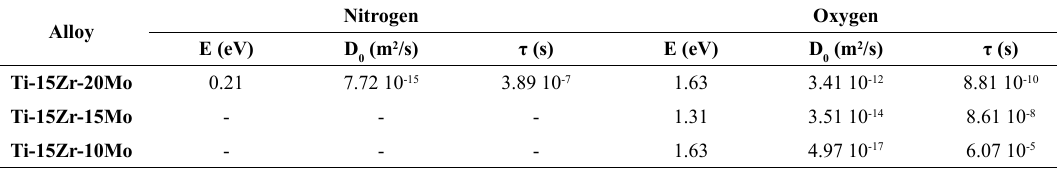
the size of hole spaces in the metallic matrix 10 . Vicente and xMo (x=5, 10, and 15 wt%), obtaining diffusivity values around 10 -8 m 2 /s. However, the oxygen content of these alloys remained lower than 0.05 wt%. Martins Jr. et al. 19